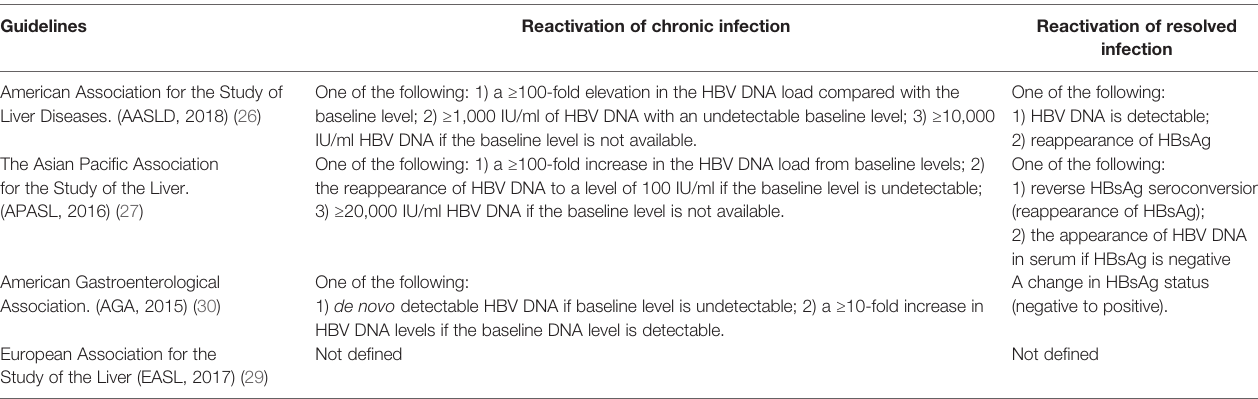
TABLE 1 | De fi nition of HBV-R according to different